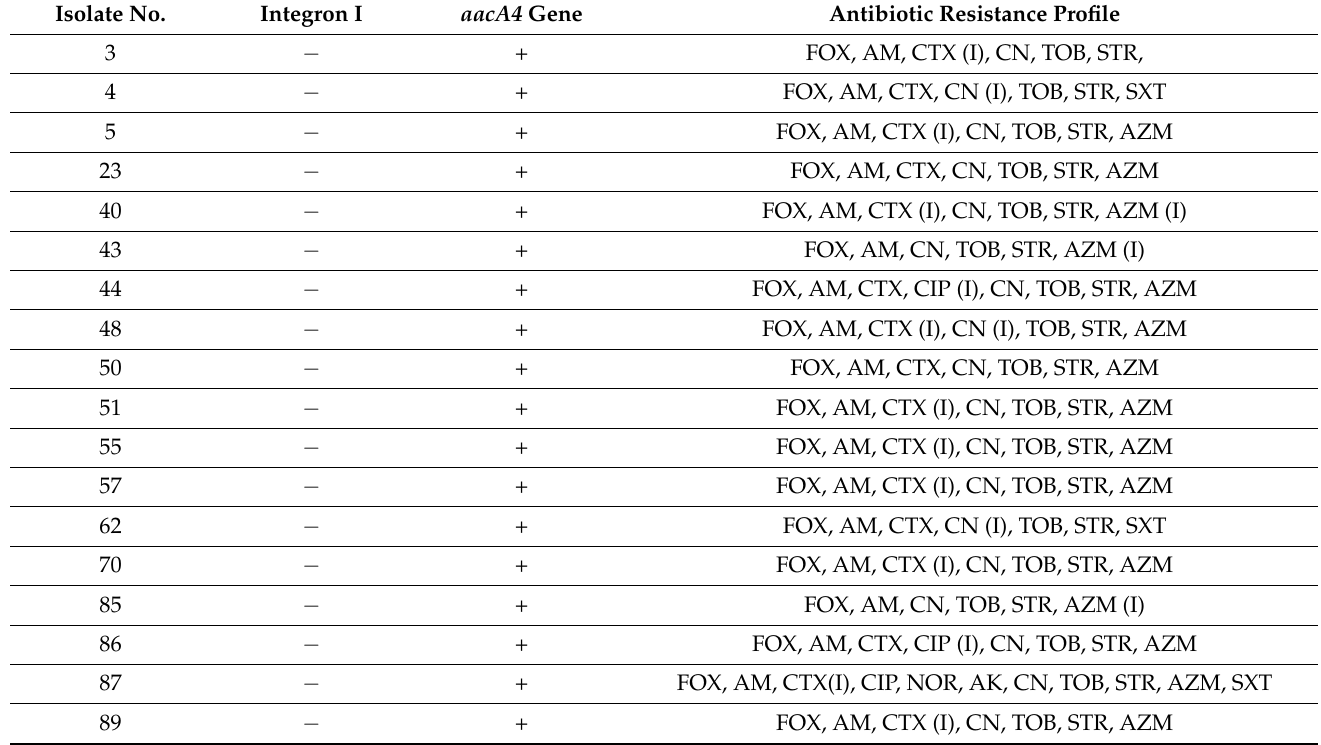
Table 2. Resistance profile of integron-negative / aacA4 -positive MRSA